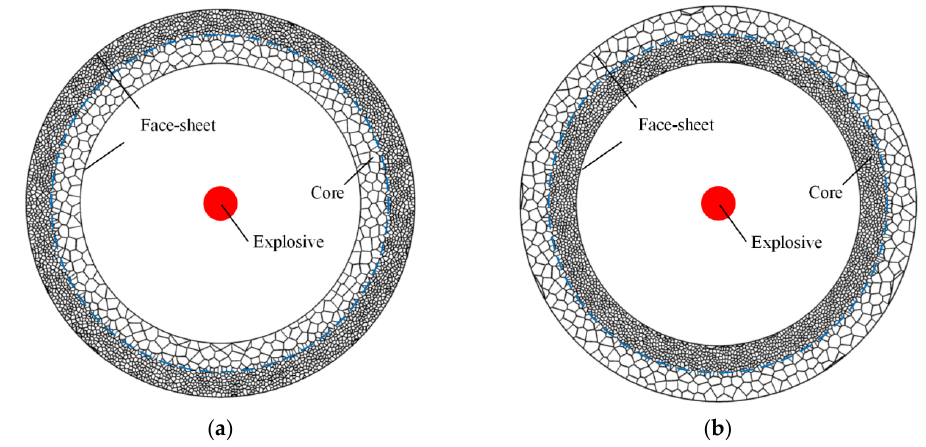
Figure 12. Finite element (FE) models [29]. ( a ) Positive gradient core, and ( b ) negative gradient core.